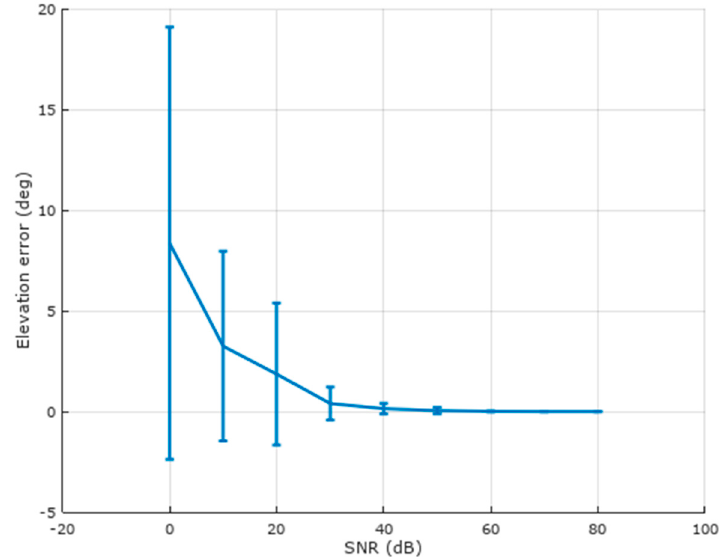
Figure 6. Elevation error vs. signal-to-noise (SNR) ratio for the spherical model. Mean and standard deviation are shown for 250 randomized trials at each SNR. The elevation range for candidate sources is 0 to 90 degrees.